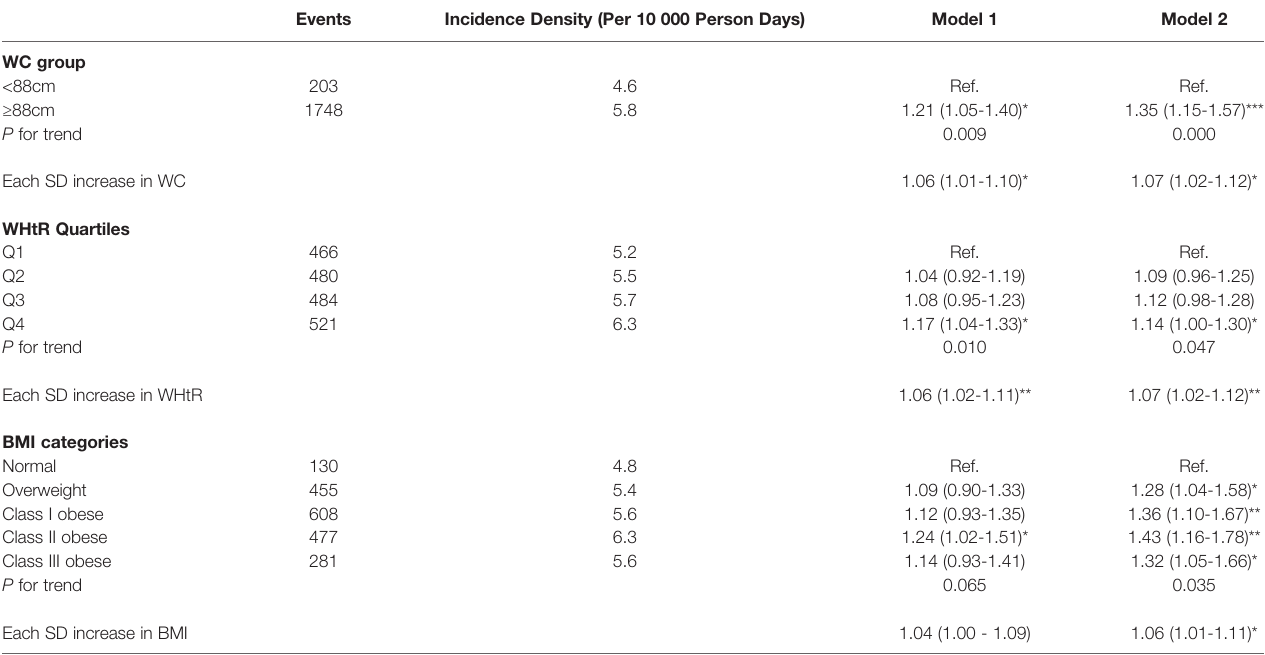
TABLE 3 | Hazard ratios for incident DN, by WC, WHtR, and BMI among women with diabetes